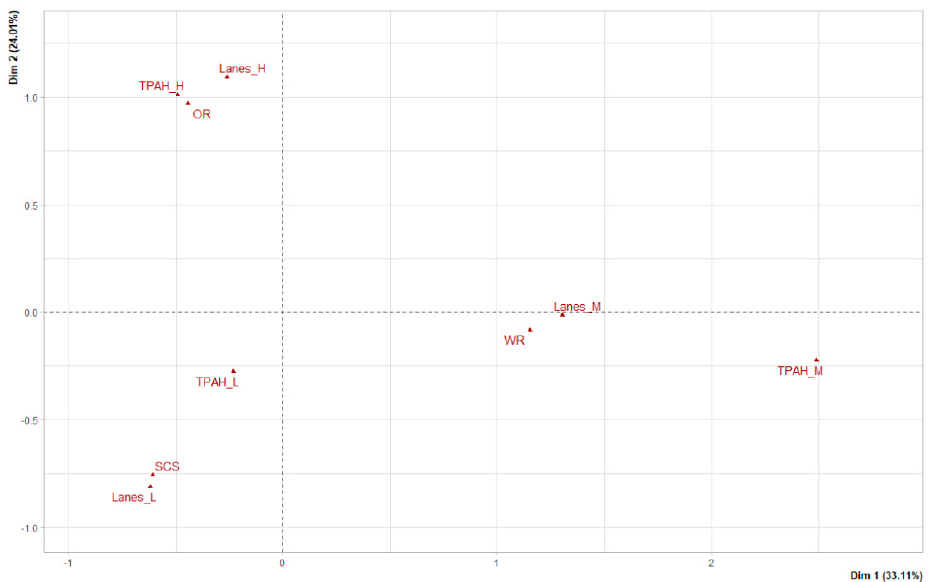
Figure 6. Representation of the variables of the multiple correspondence analysis. TPAH_H, higher total concentrations of PAH; Lanes_H, higher number of lanes; OR, open roads; TPAH_L, lower total concentrations of PAHs; SCS, shallow canyon streets; Lanes_L, lower number of lanes; Lanes_M, medium number of lanes; WR, wide road; TPAH_M, medium total concentrations of PAHs.